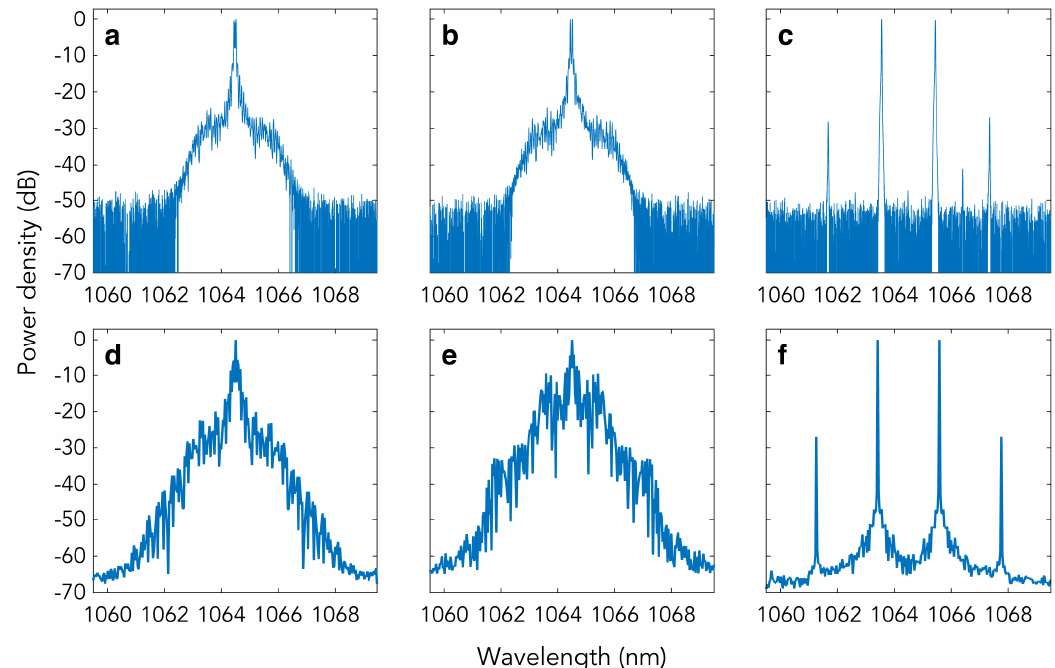
Figure 8. ( a – c ) Experimental OPO optical spectra for detunings ∆ = − 0.30,0.00,0.30, respectively. ( d – f ) Corresponding numerically calculated spectra. From [54]. Copyrighted by the American Physical